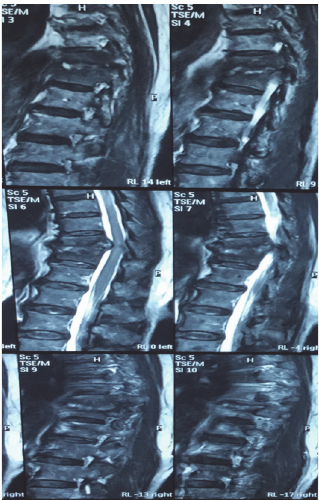
Figure 1: MRI thoracic spine T10-T11 discitis with minimal soft- tissue component and vertebral body.